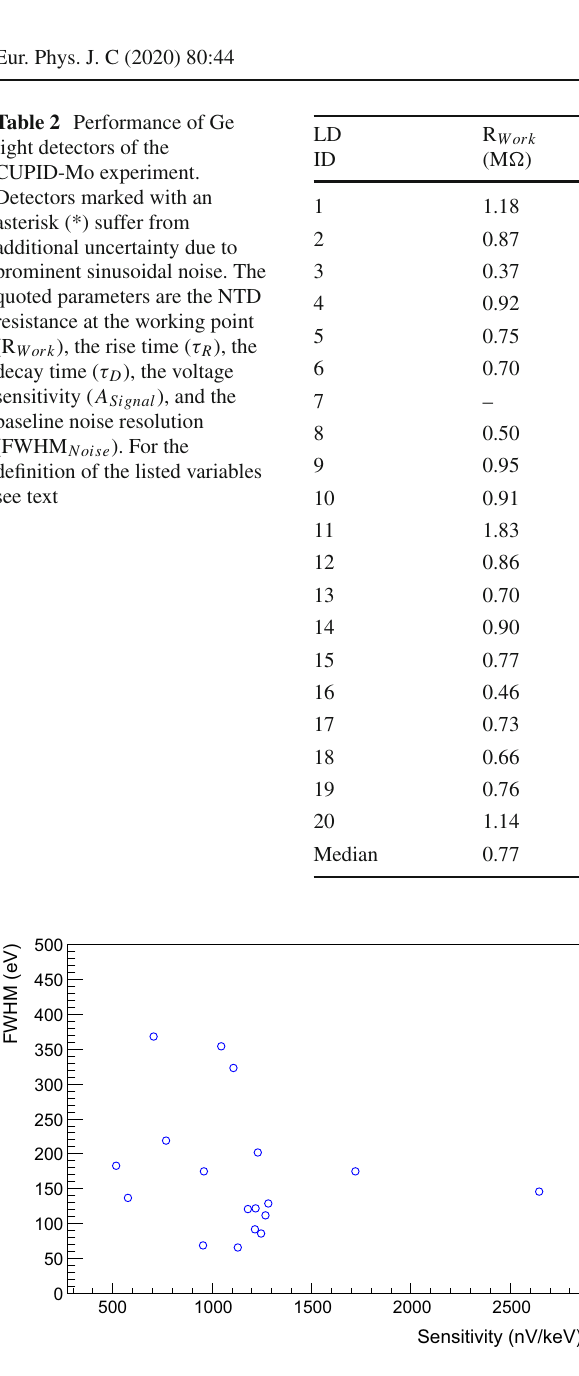
Fig. 10 The baseline resolution versus sensitivity for 18/20 Ge LDs operated in the CUPID-Mo experiment at 20.7 mK. One detector is discarded due to having a different NTD (LD 3), while the second is not operational( LD 7, see